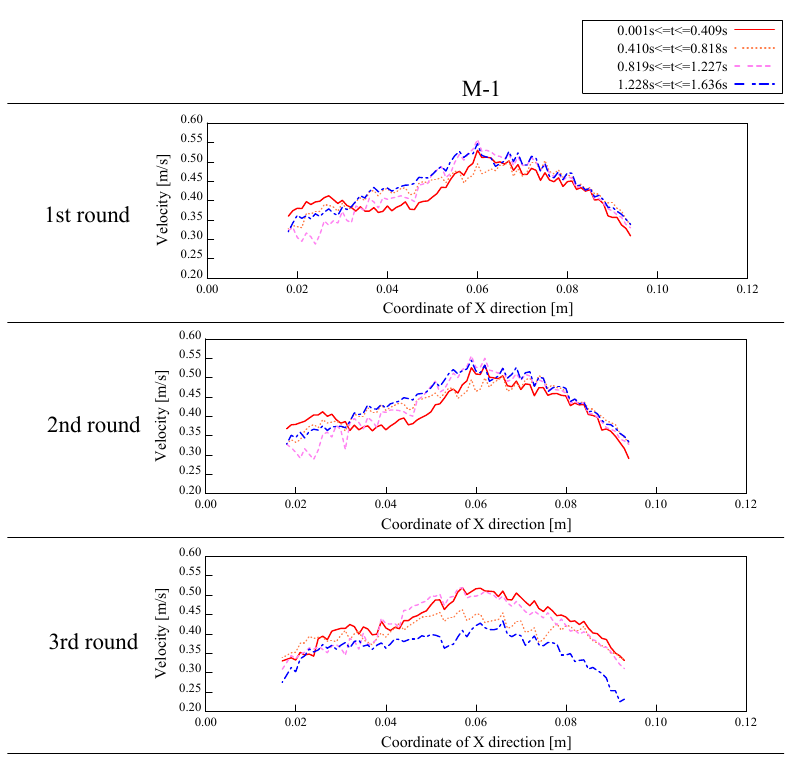
Figure 12. Relationship of the flow velocities in each cross section by combining the horizontal and vertical flow velocities for every 409 frames (0.409 s) of four 1636 frames from M-1.